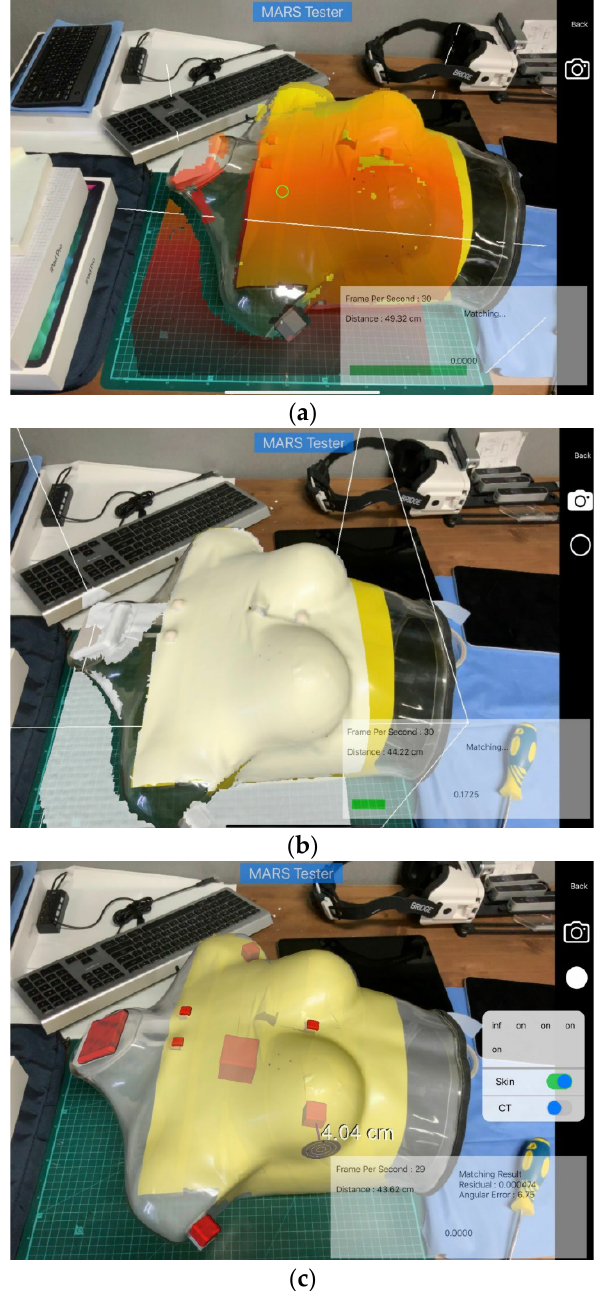
Figure 4. Phantom data registration and AR visualization. ( a ) 3D scan process. ( b ) Skin mesh AR visualization. ( c ) Cube AR visualization.